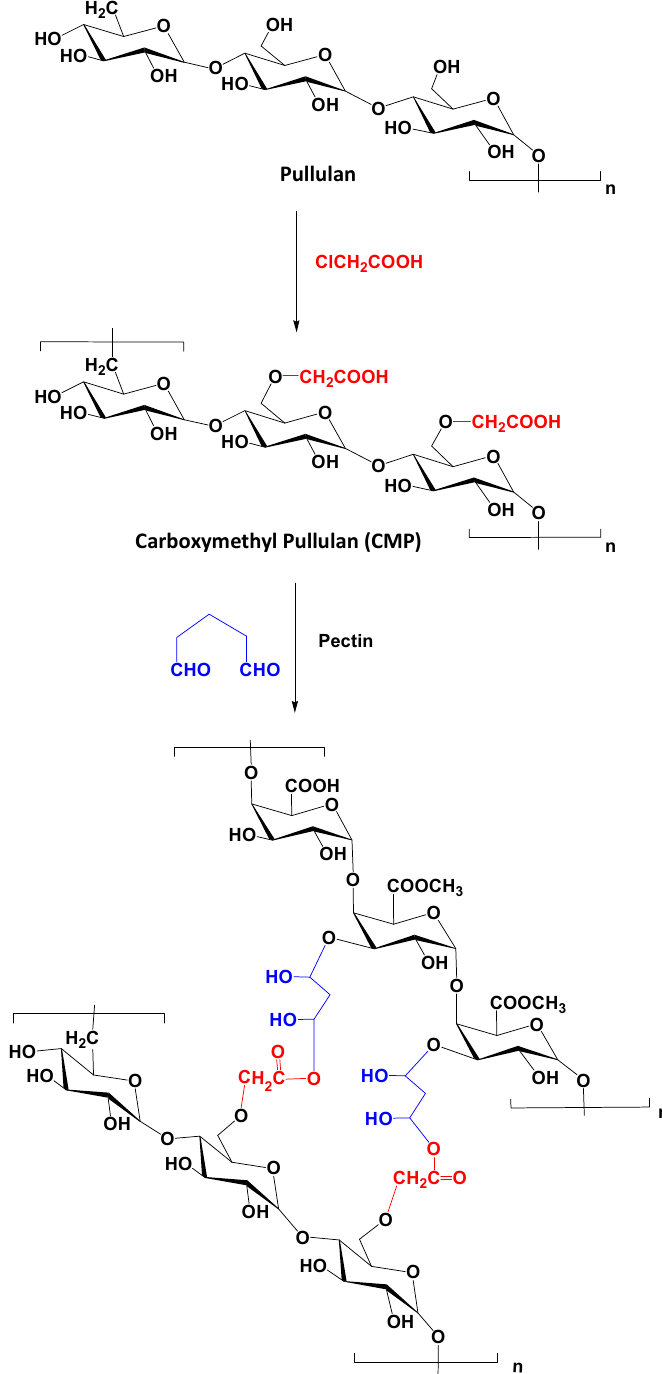
Figure 1. Schematic preparation of Pe@CMP hydrogel.